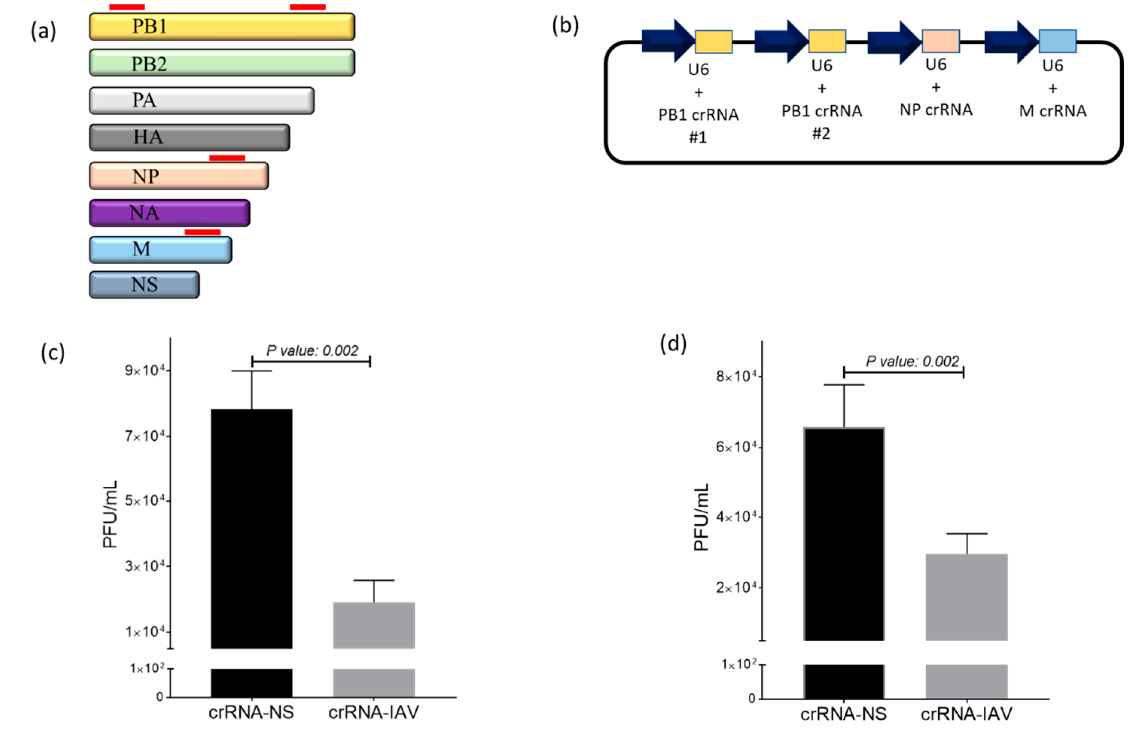
Figure 2. Evaluation of IAV inhibition using CRISPR/Cas13 in DF1 cells. ( a ) Schematic diagram of designed crRNAs in the IAV viral genome. A redline on the PB1, NP and M gene denotes the position of each crRNA. ( b ) Schematic of the pcrRNA-IAV construct developed to express four crRNAs targeting the PB1, NP and M genes of IAV. ( c , d ) DF1-Cas13a cells were transfected with pcrRNA-IAV or pcrRNA-NS 24 h and infected with WSN ( c ) and PR8 ( d ) at an MOI of 0.1. Supernatant fluids were collected at 24 hpi to measure viral replication by plaque assays. The results are the pool of two separate experiments ( n = 6). The error bars correspond to standard deviation. The p value indicates significance between the two treatment groups.